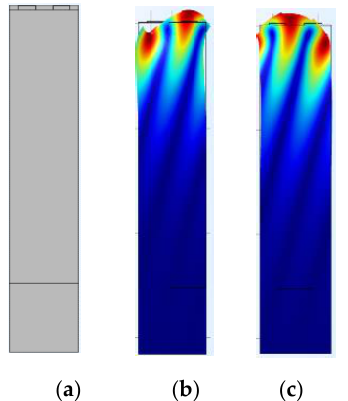
Figure 9. Finite element model (FEM) analysis applied to the acoustic modes in Pt/LGS: ( a ) device structure in FEM, ( b ) symmetric model, and ( c ) antisymmetric model.